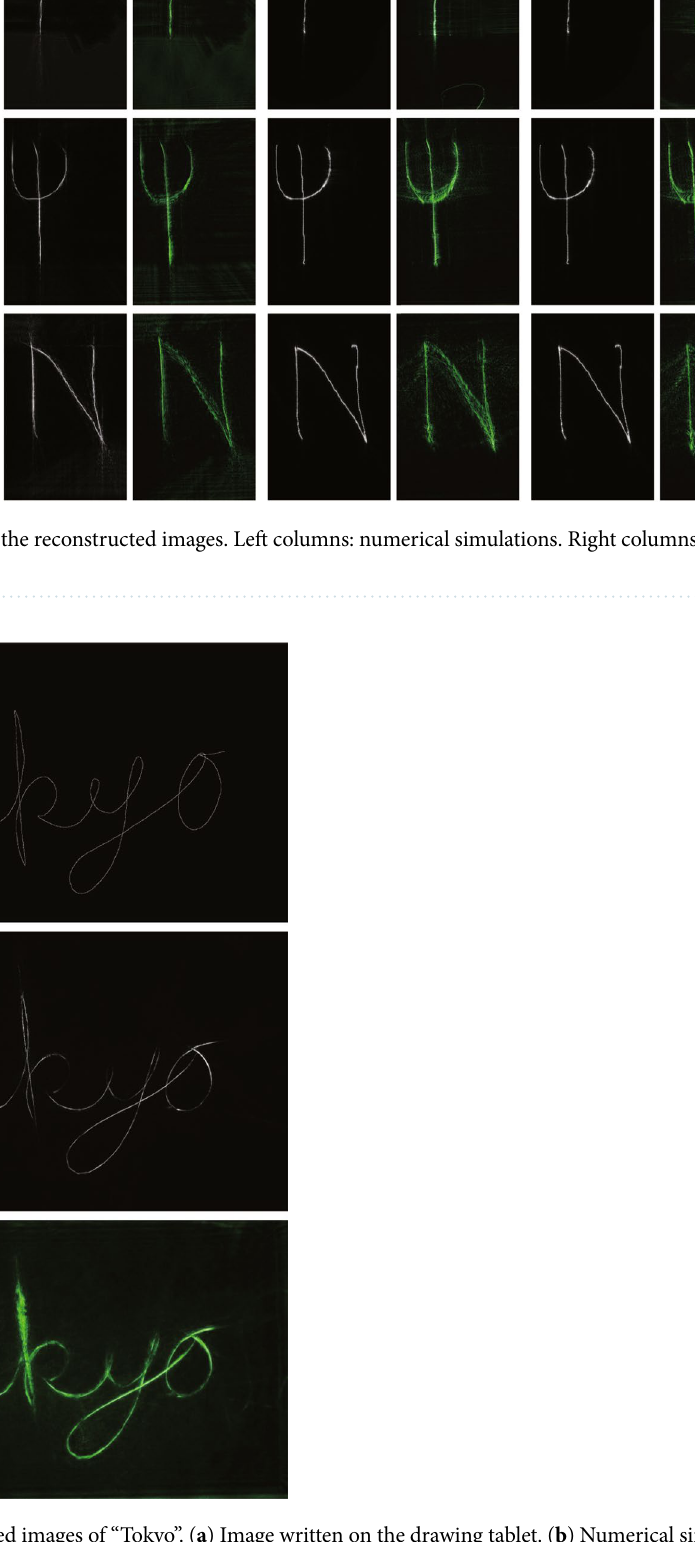
Figure 8. Reconstructed images of “Tokyo”. ( a ) Image written on the drawing tablet. ( b ) Numerical simulations. ( c ) Optical